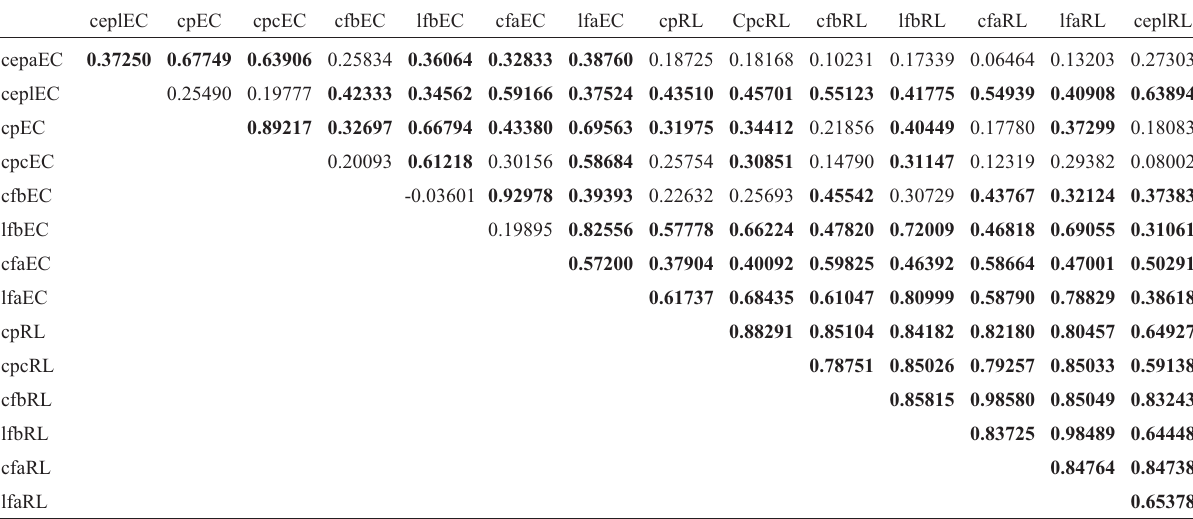
Trait codes: distal leaflet lengths on main axis (cfaEC); basal leaflet lengths on main axis (cfbEC); distal leaflet widths on main axis (lfaEC); basal leaflet widths on main axis (lfbEC); petiolule length on main axis (cpcEC); petiole length on main axis (cpEC); length of the adnate portions of the stipules on main axis (cepaEC); length of the free portions of the stipules on main axis (ceplEC); distal leaflet lengths on lateral branches (cfaRL); basal leaflet lengthsonlateralbranches(cfbRL);distalleafletwidthsonlateralbranches(lfaRL);basalleafletwidthsonlateralbranches(lfbRL);petiolelengthonlat- eral branches (cpRL); petiolule length on lateral branches (cpcRL); length of the free portions of the stipules on lateral branches (ceplRL). Bold data show correlation between traits at 5%